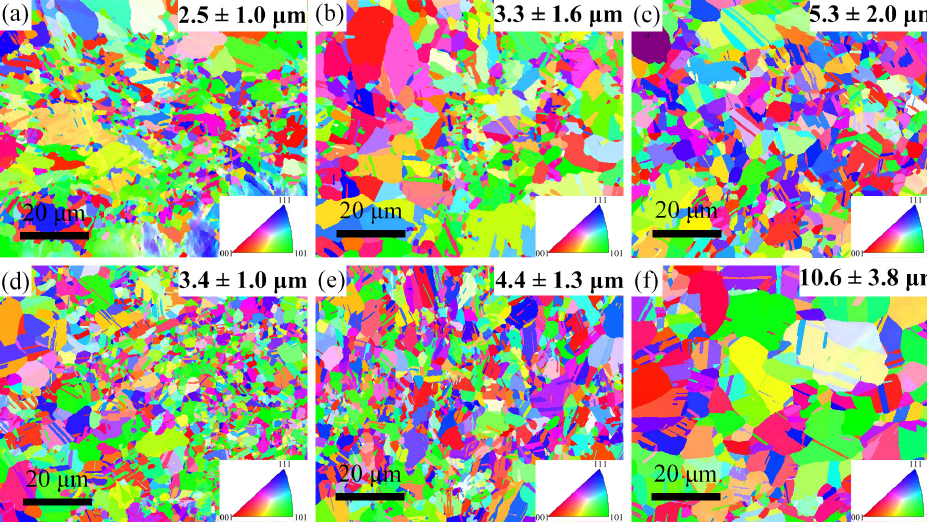
Figure 1. EBSD IPF maps of the ( a ) 0Al ‐ 973 K, ( b ) 0Al ‐ 1023 K, ( c ) 0Al ‐ 1123 K, ( d ) 5Al ‐ 973 K, ( e ) 5Al ‐ 1023 K, and ( f ) 5Al ‐ 1123 K specimens.